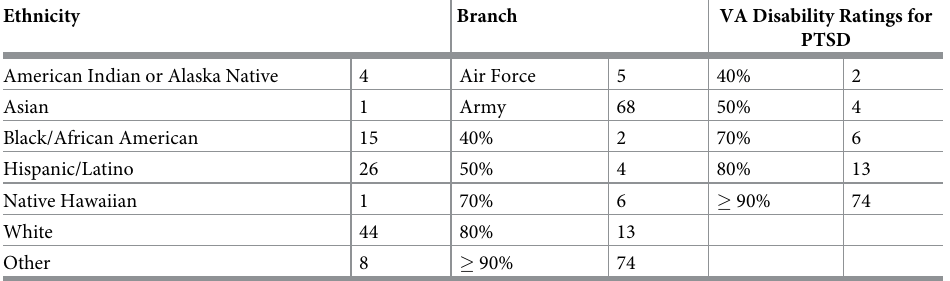
Table 1. Participants’ demographics; the numbers show the number of veterans per each